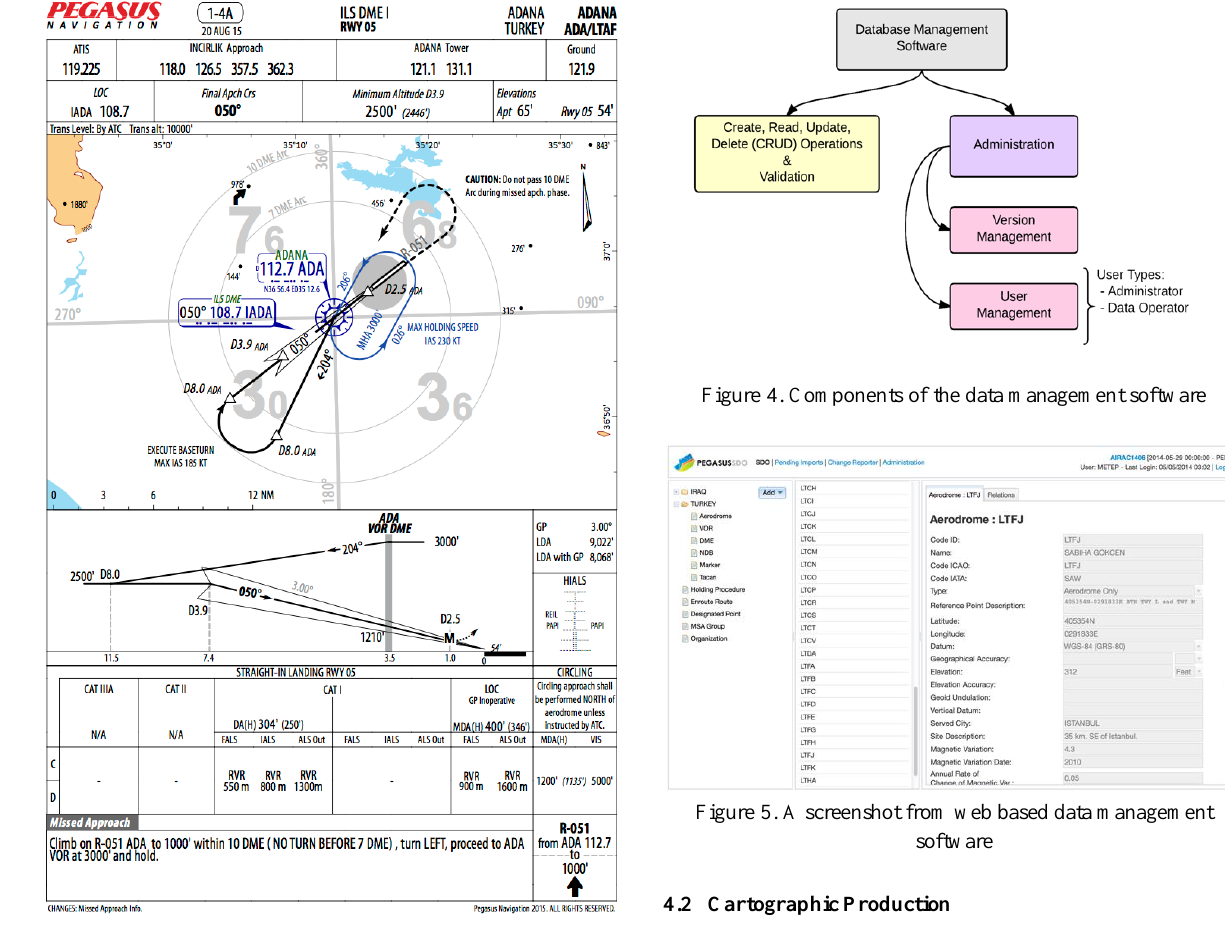
Figure 3. An example of Instrument Approach Chart